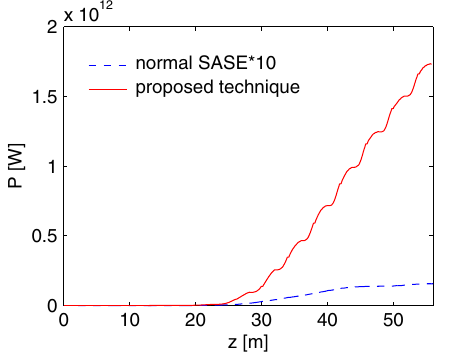
FIG. 4. FEL peak power gain curves for normal SASE (blue dashed line) and the proposed scheme (red solid line).